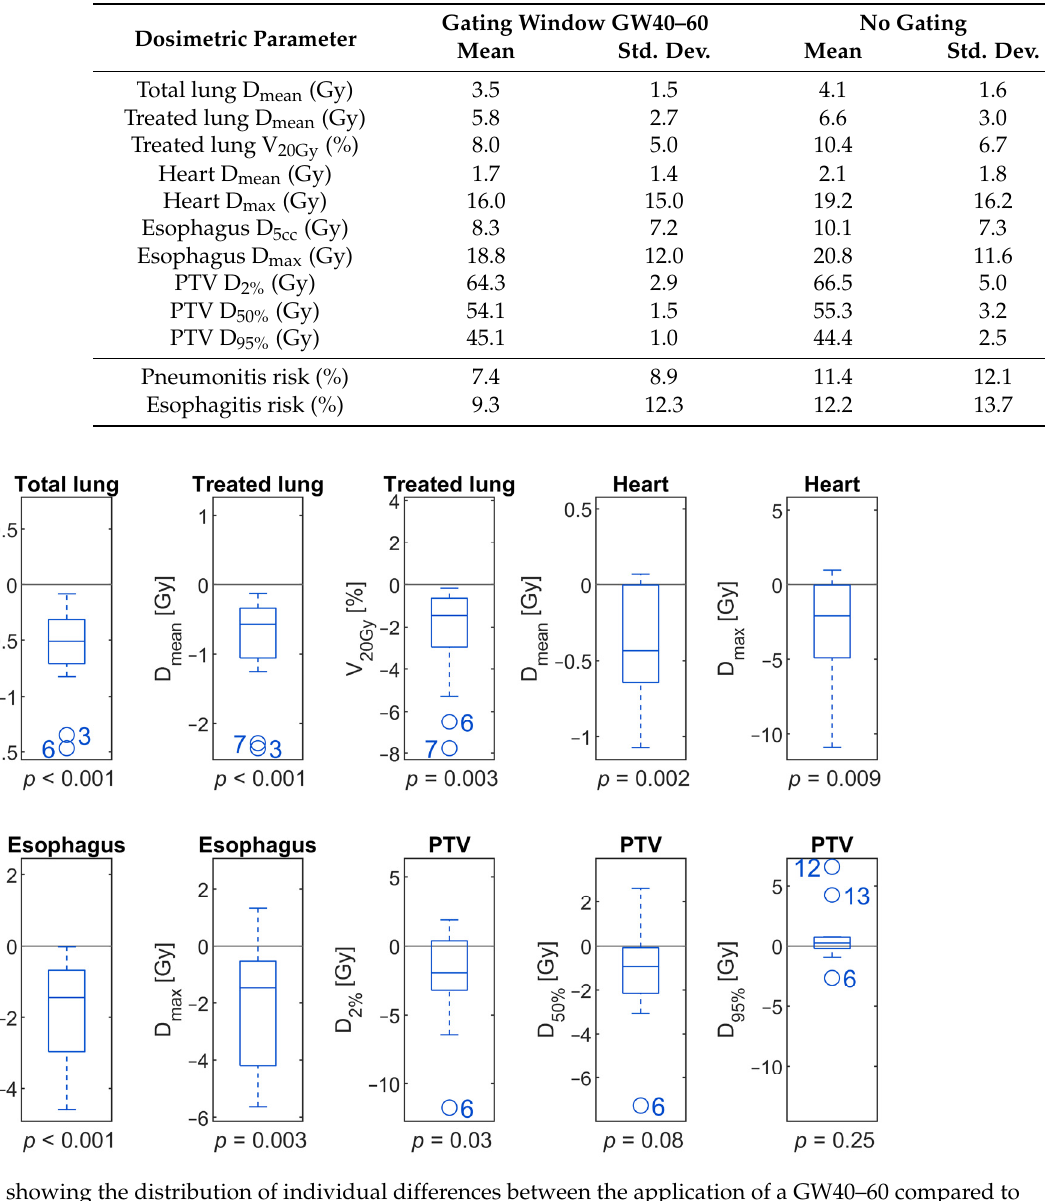
Figure 1. Boxplots showing the distribution of individual differences between the application of a GW40–60 compared to no gating. Boxes show interquartile ranges with the median denoted by a separating line. Outliers are marked by circles and patient case numbers.